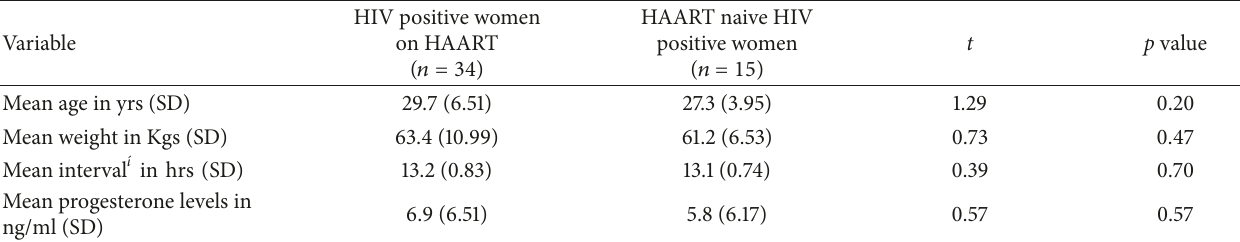
Table 1: Comparison of variables between HIV positive women on HAART and HAART naive HIV positive women taking combined oral contraceptive pills between October 2015 and March 2016 at TASO Clinic, Mulago Hospital.